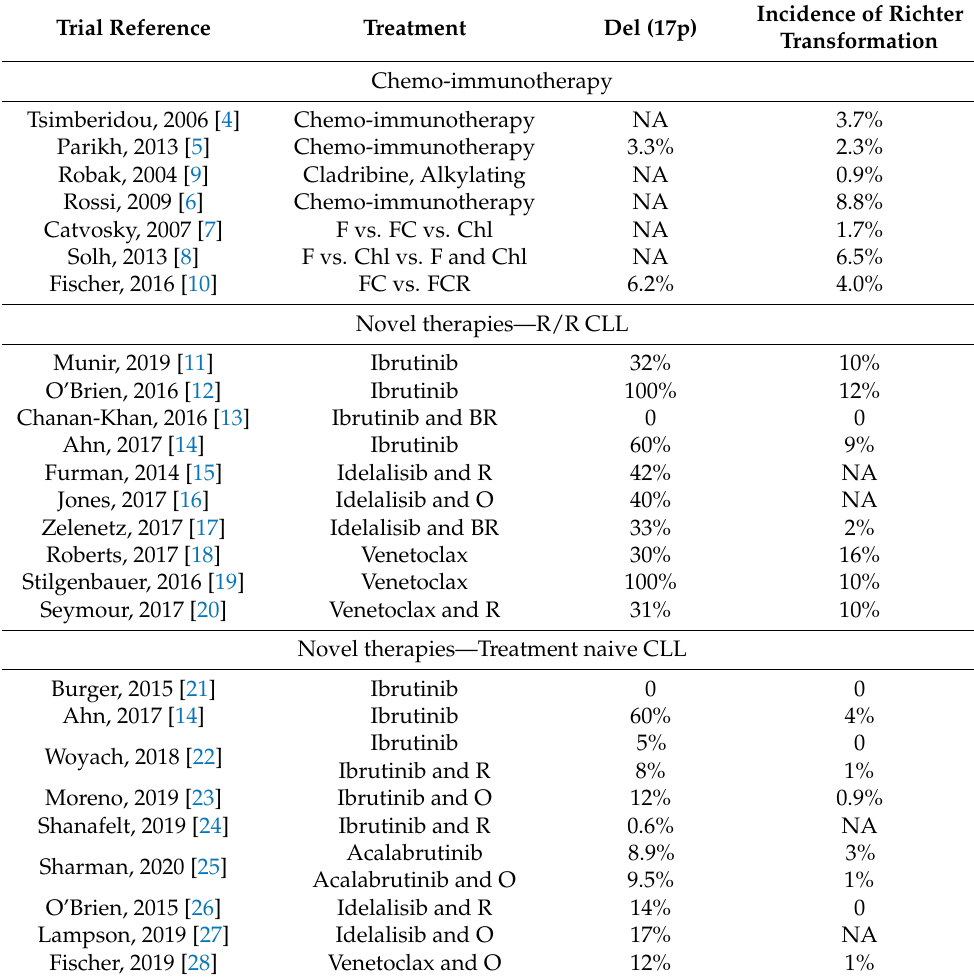
Table 1. Epidemiology of Richter transformation reported in clinical trials in the era of chemoim- munotherapy and novel